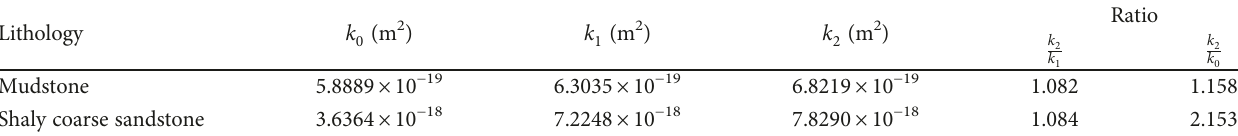
Ratio k 2 k 2 k 1 k 0